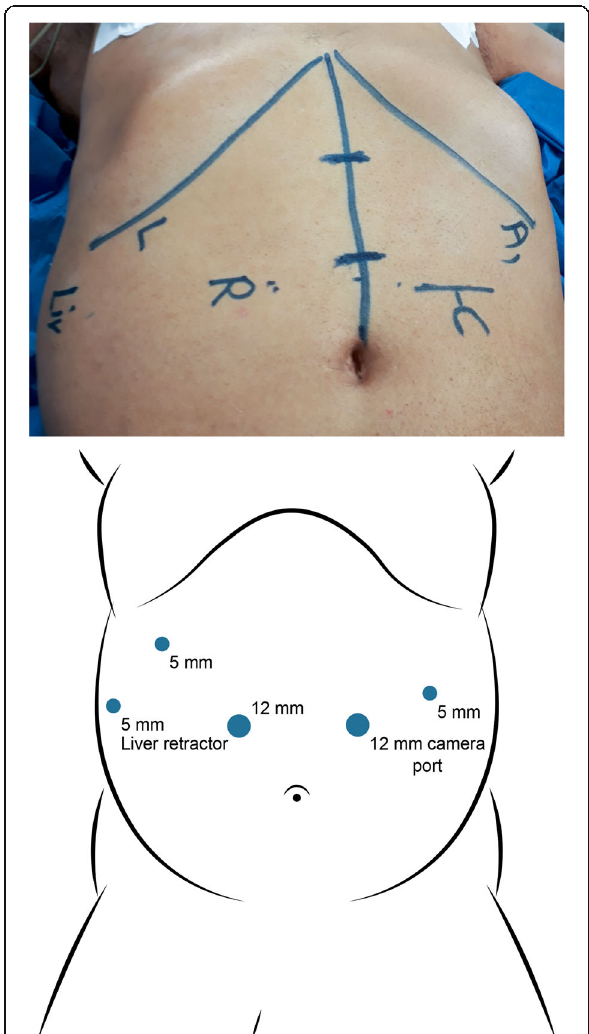
Fig. 1 Port placement. C: camera port, R: right working port, L: left working port, A: assistant port, Liv: liver retractor